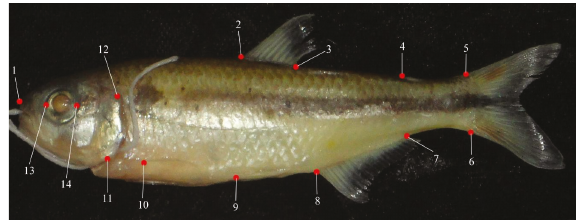
Figure 2: Analyzed landmarks: 1: rostrum; 2: anterior insertion; 3: posteriorinsertion of dorsal fin; 4: posterior insertion of adipose fin; 5: superior insertion of the first ray of caudal fin; 6: inferior insertion of final ray of caudal ray; 7: posterior insertion; 8:anterior insertion of anal fin; 9: insertion of ventral fin; 10: insertion of pectoral fin; 11: inferior limit; 12: superior limit of operculum; 13: anterior limit; 14: posterior limit of ocular